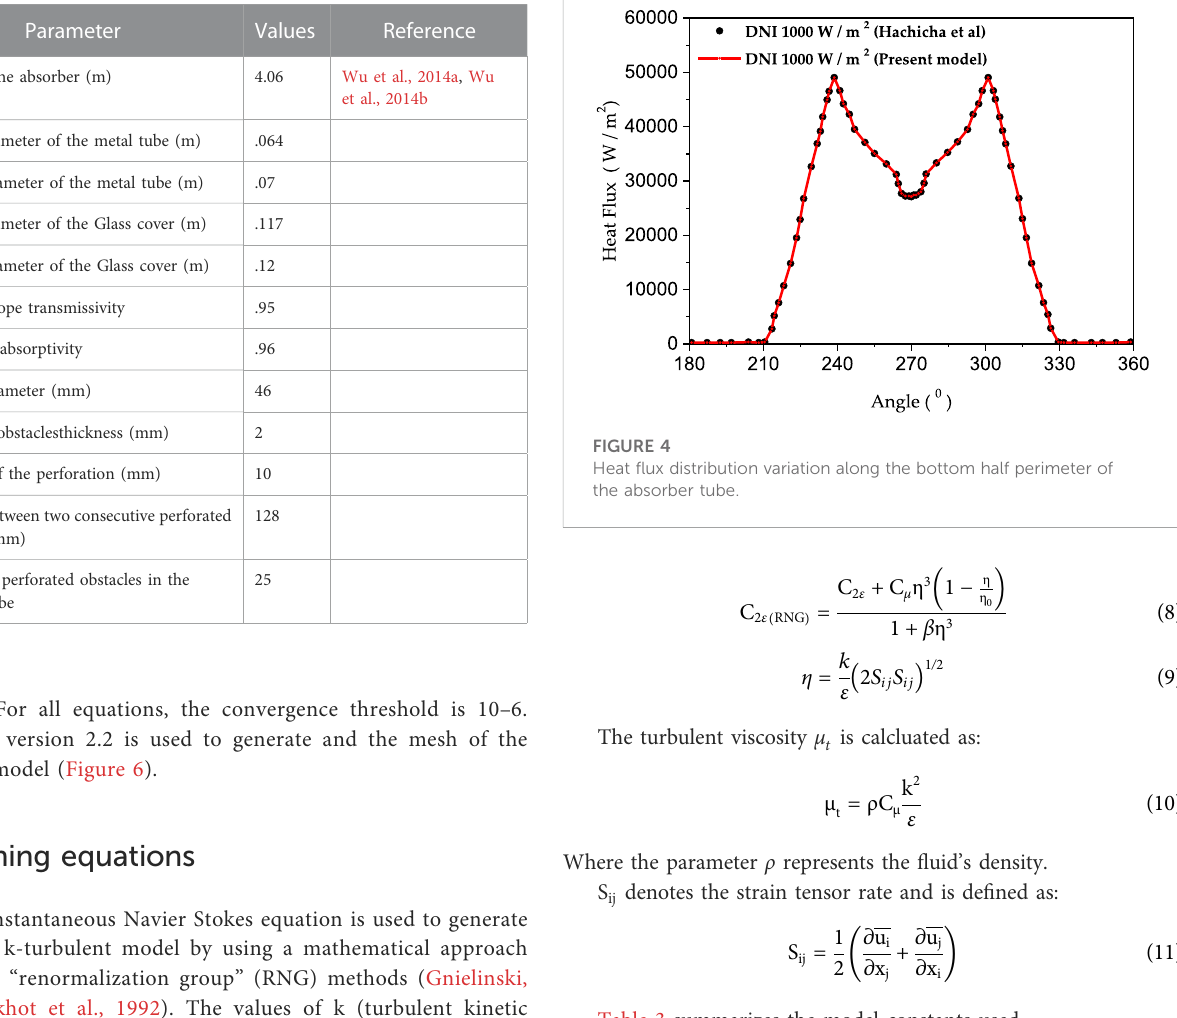
Table 3 summarizes the model constants used.